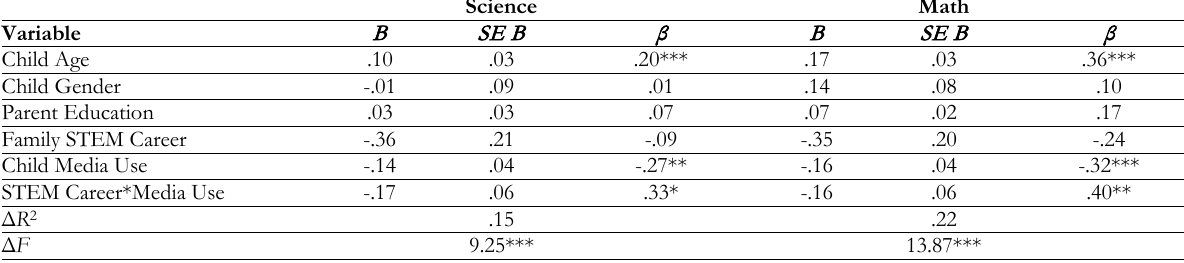
Table 2. Regression analyses for children’s science and math